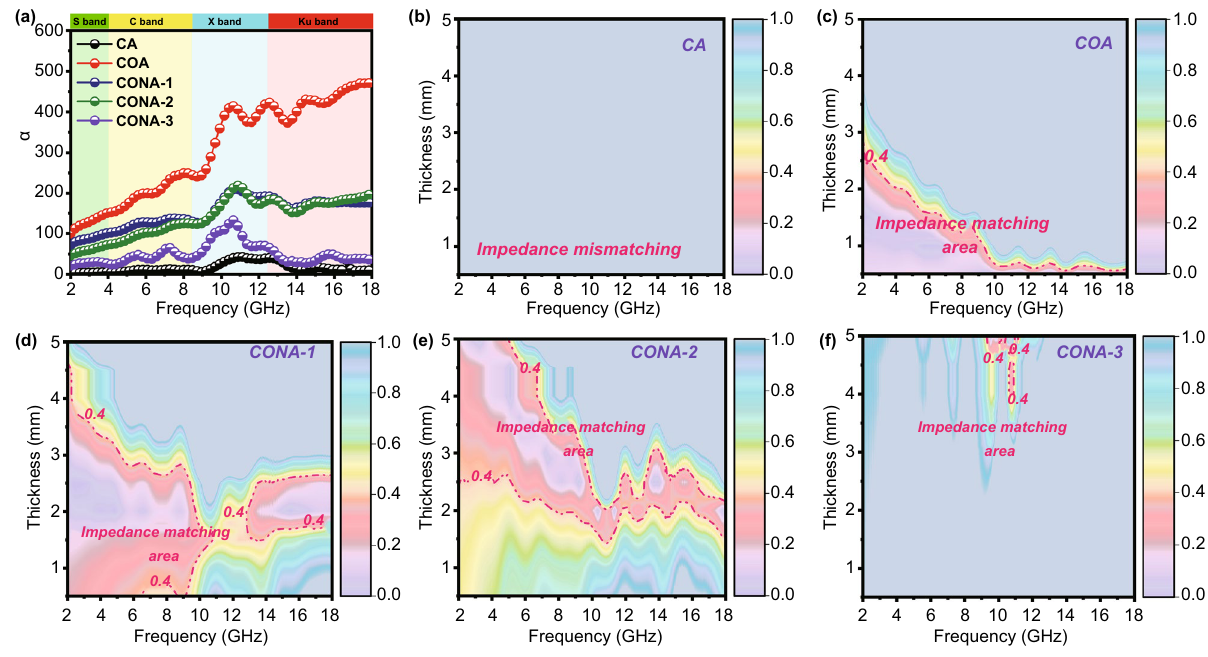
▵ value maps: b CA, c COA, d CONA-1, e CONA-2 and f